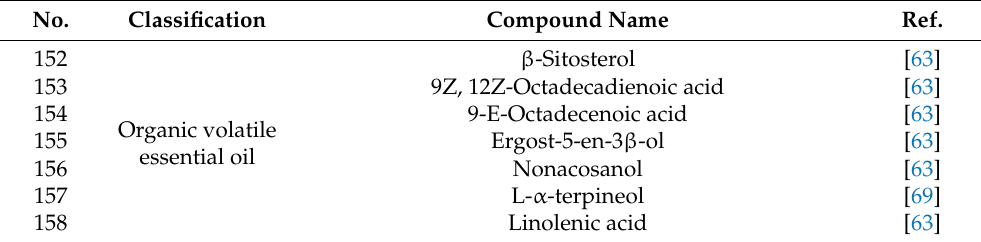
Table 5. Organic volatile essential oil in Ephedra sinica Stapf (structural formulas are shown in Figure S5). No.